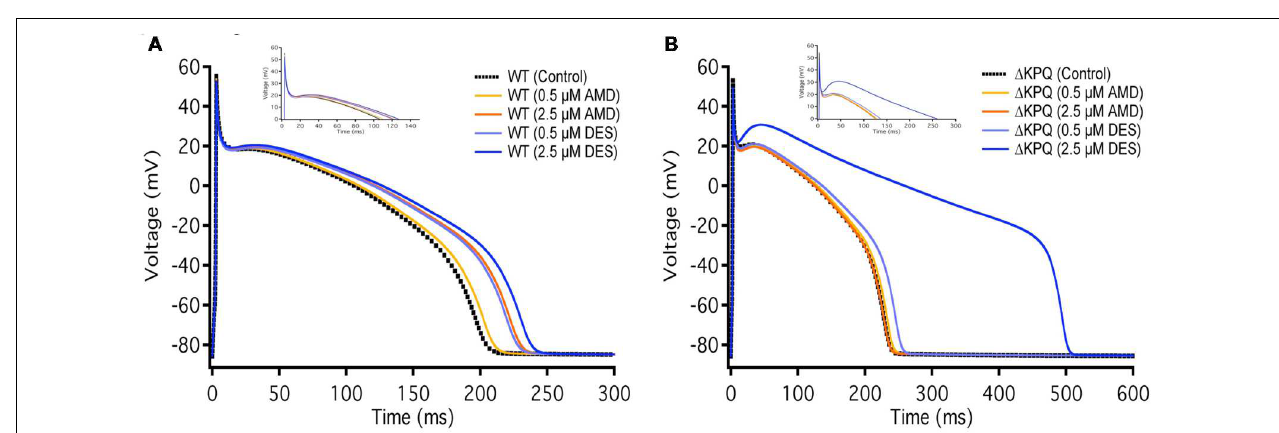
FIGURE 8 | Action potential model simulation. (A) Shows the simulations belonging to WT Na v 1.5, where the black curve represents control, light and dark orange curves represent AMD perfusion at 0.5 and 2.5 µ M, respectively, and light and dark blue curves represent DES perfusion at 0.5 and 2.5 µ M, respectively. (B) Shows the simulations belonging to (cid:49) KPQ, where the black curve represents control, light and dark orange curves represent AMD perfusion at 0.5 and 2.5 µ M, respectively, and light and dark blue curves represent DES perfusion at 0.5 and 2.5 µ M, respectively.